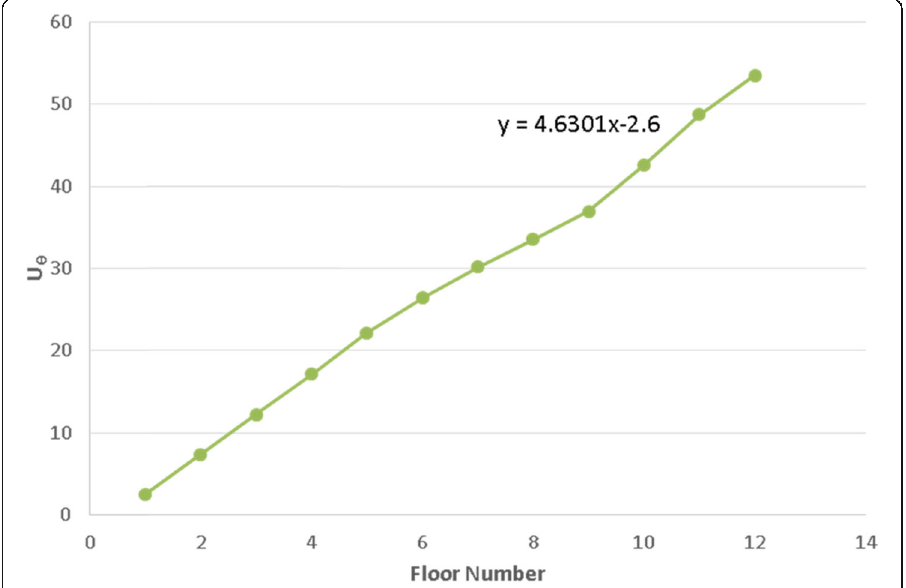
Fig. 36 Floor number — U Ɵ relationship (0.6